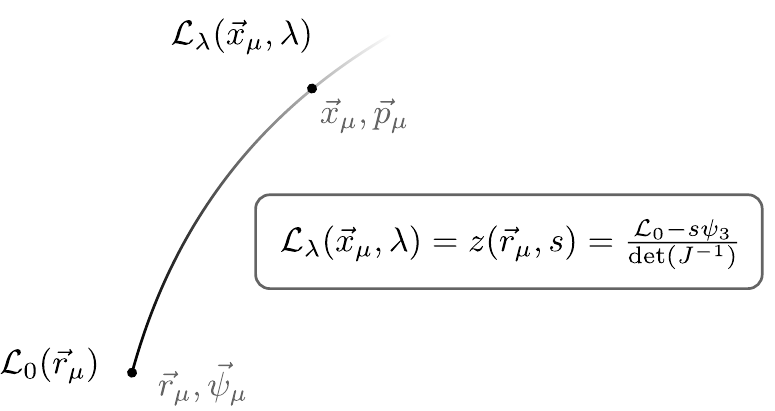
Figure 2 . T ¯ T flow as characteristic flow. The undeformed variables are ~r µ , ~ψ µ , L 0 and the deformed variables are ~x µ , ~p µ , L λ